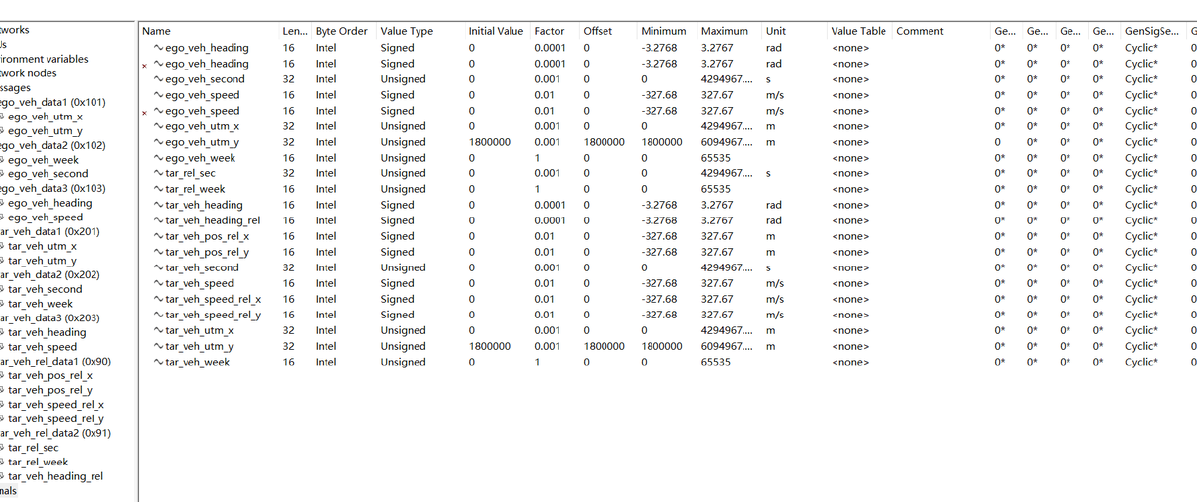
Figure 15. The CAN signal.